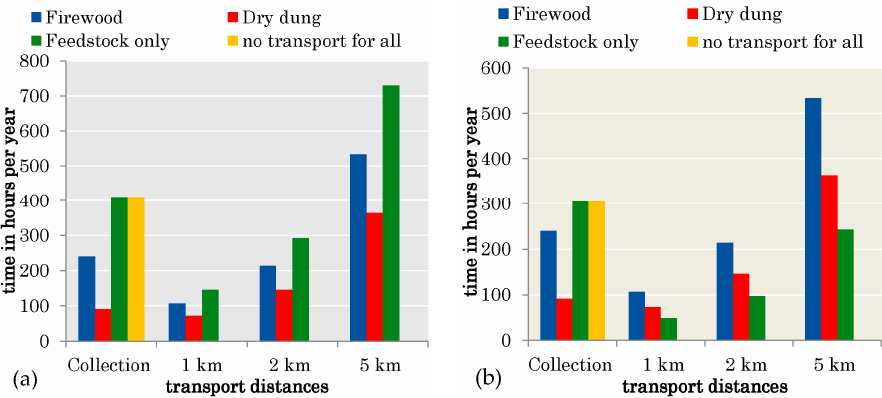
Figure 4. Comparison of average time spent on collection and transportation of biomass, water, and slurry with: ( a ) mono ‐ digestion; and ( b ) co ‐ digestion biogas systems without transportation of water and slurry with: ( a ) mono-digestion; and ( b ) co-digestion biogas systems without transportation of and slurry. water and